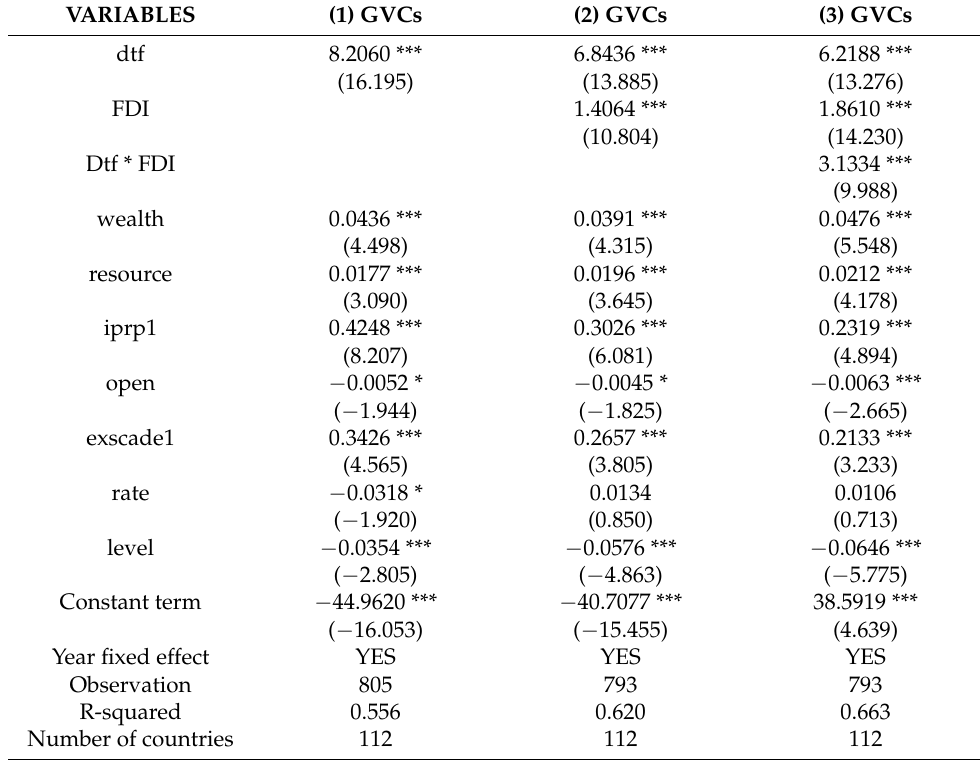
Table 2. Business environment’s impact on BRI countries’ status elevation on the global value